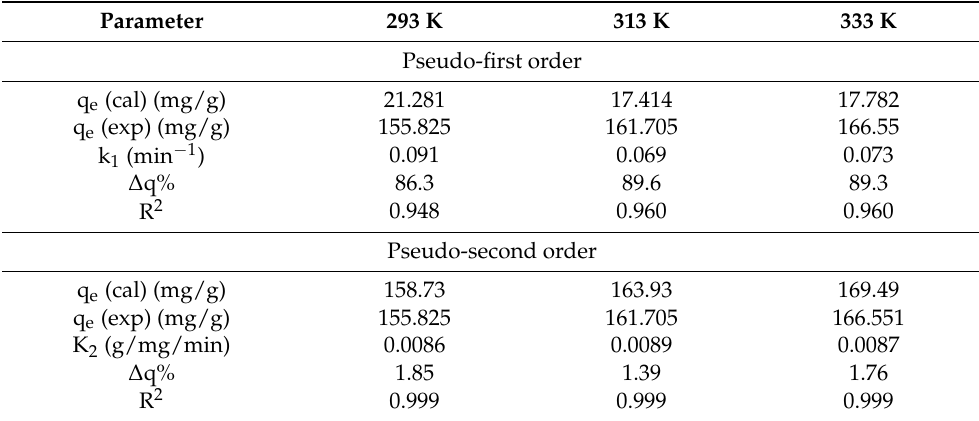
Figure 6. Kinetic models: ( a ) pseudo-first-order kinetics model; ( b ) pseudo-second-order kinetics model; ( c ) intraparticle diffusion model; ( d ) Elovich model; ( e ) Natarajan and Khalaf model. Table 2. Temperature-dependent parameters of pseudo-first- and pseudo-second-order kinetics for adsorption of BB-3 on